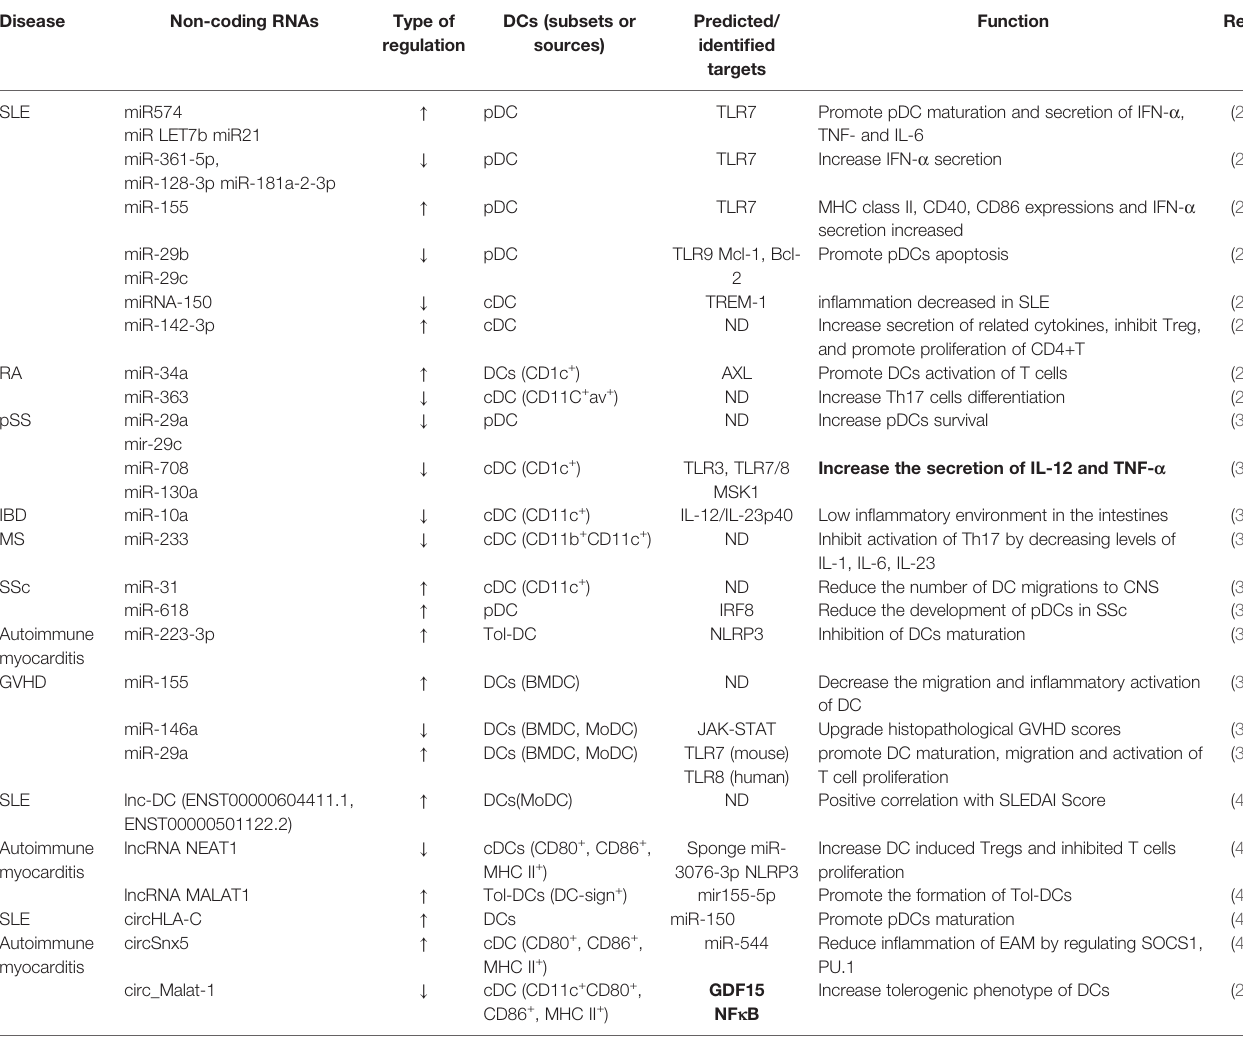
TABLE 1 | The targets and regulatory effect of noncoding RNAs on DCs in autoimmune and immune tolerance-related diseases. Disease Non-coding